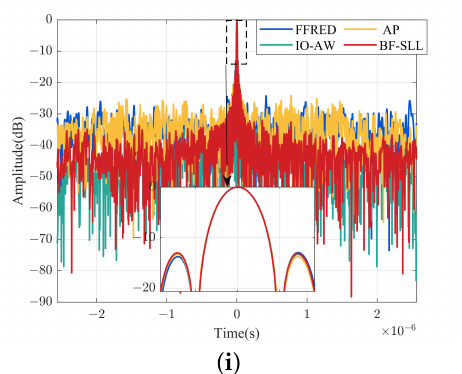
Figure 5. The synthetic waveform matched filtering results from several angles. ( a ) Matched filtering result in direction 29.87 ◦ . ( b ) Matched filtering result in direction 33.87 ◦ . ( c ) Matched filtering result in direction 35.87 ◦ . ( d ) Matched filtering result in direction 36.37 ◦ . ( e ) Matched filtering result in direction 36.87 ◦ . ( f ) Matched filtering result in direction 37.87 ◦ . ( g ) Matched filtering result in direction 38.87 ◦ . ( h ) Matched filtering result in direction 40.87 ◦ . ( i ) Matched filtering result in direction 43.87 ◦ .